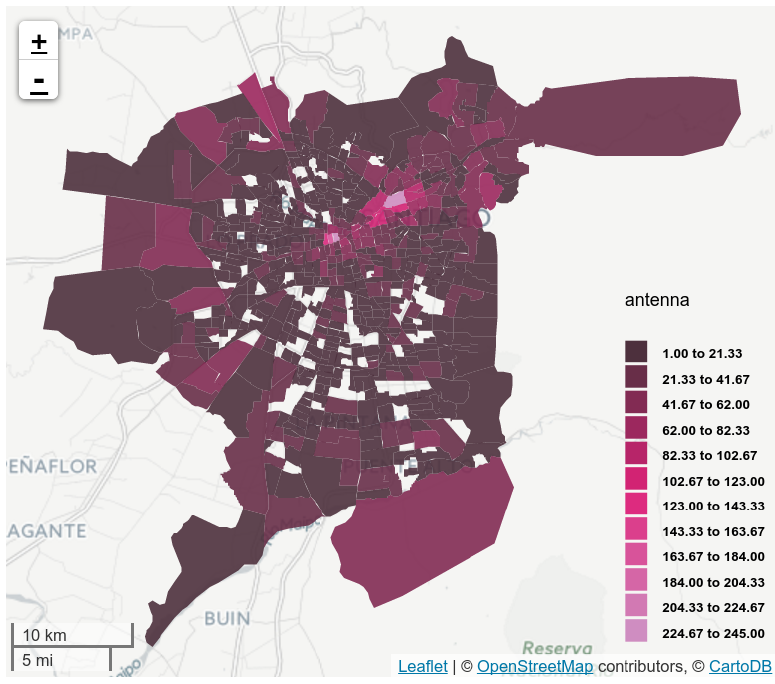
Figure 3. Antenna coverage on the 752 zones from the ODS zoning, using the corresponding BTS positions. Colors indicate antenna density in each